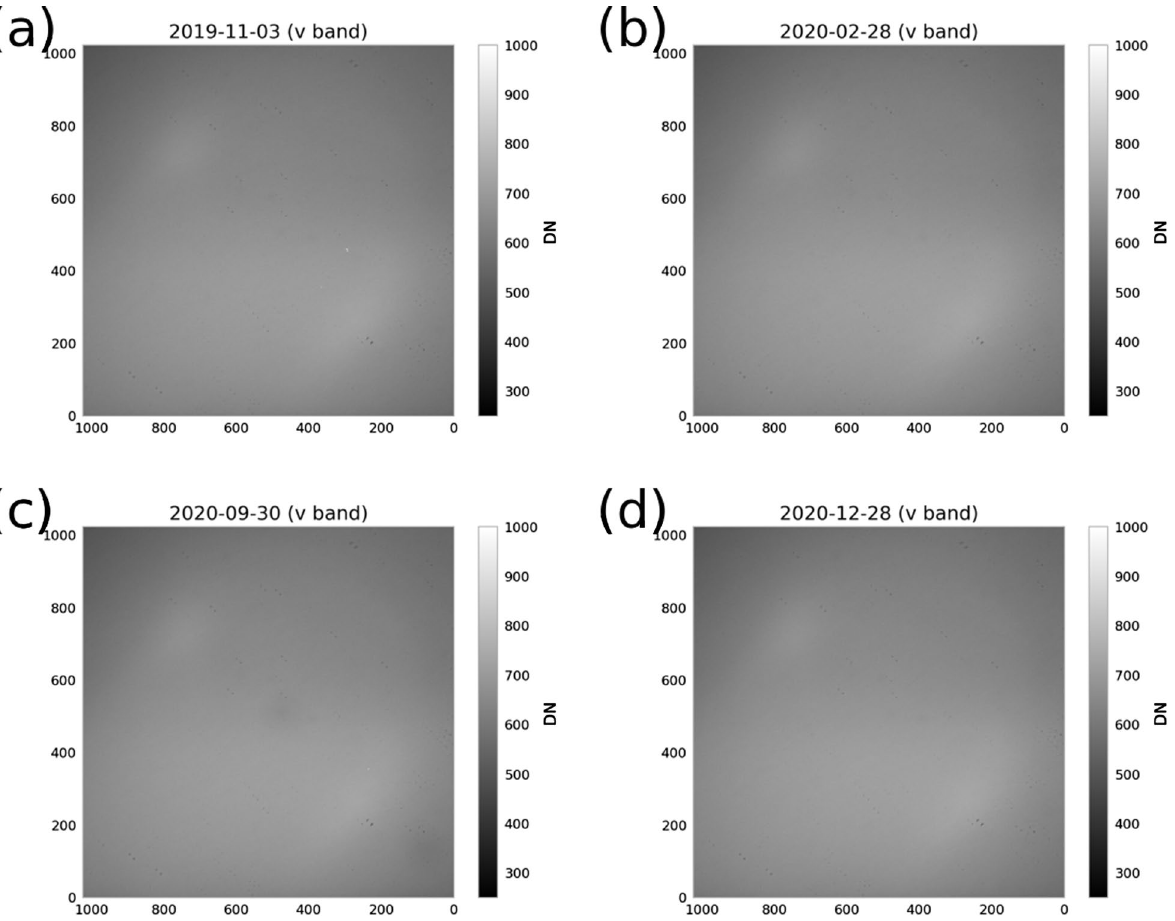
Fig. 3 ONC-T v-band FF-lamp images acquired from just before departure from Ryugu (November 3, 2019) to after capsule re-entry (December 28, 2020). Dark areas only appeared on September 30, 2020 near the center and lower right of the image